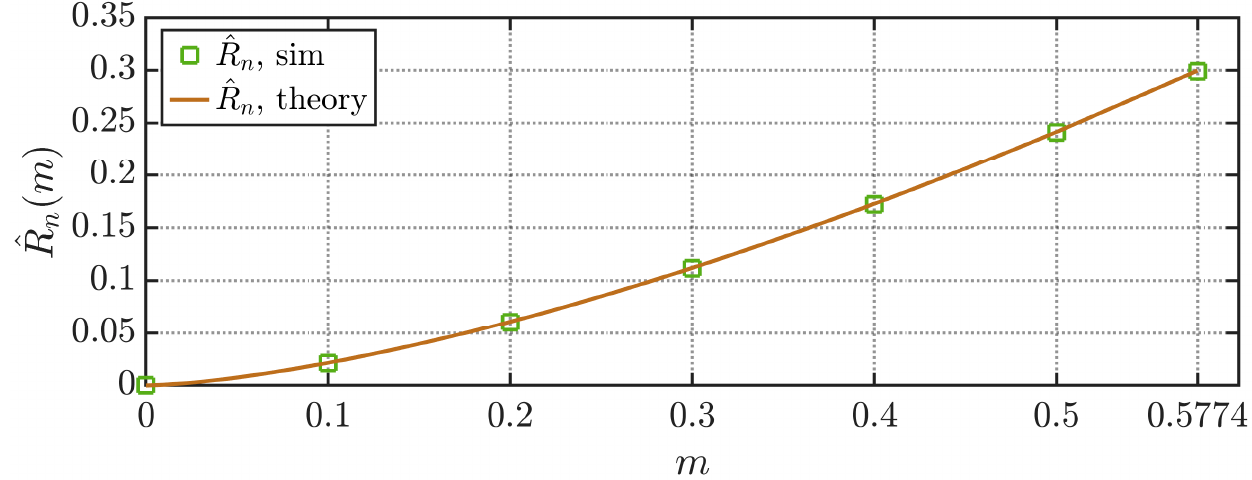
Figure 14. Normalized RMS value of neutral current ripple in case of both SPWM and CPWM (up to m = 0.5 in case of SPMW).